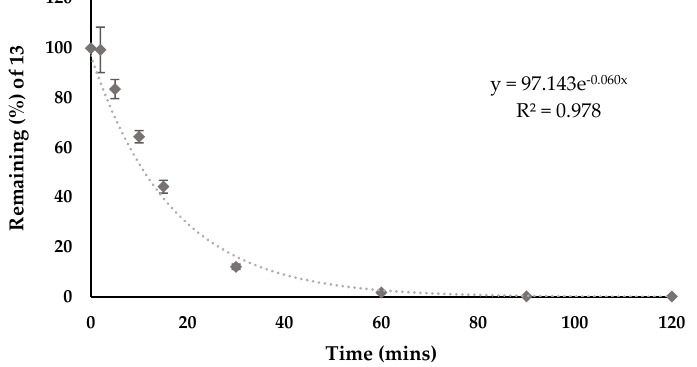
Figure 6. Stability of conjugate 13 (125 µ M) in 25% human serum. Note the trendline gives the half-life of 11.8 min with an R 2 of 0.978. Each point represents an average of three readings.